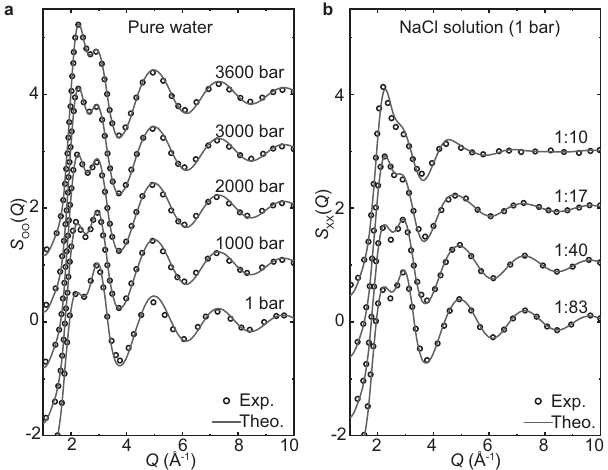
Fig. 1 Reciprocal-space structure of pure water and NaCl solutions. a Experimental 41,52 and theoretical partial structure factors S OO ð Q Þ , for O atoms in pure water at different pressures. b Experimental 18 and theoretical composite partial structure factors S XX ð Q Þ for NaCl aqueous solutions with salt: water mole ratios 1:83 to 1:10, at 1 bar. S XX ð Q Þ contains O – O, O – ion, and ion – ion correlations, S XX ð Q Þ ¼ ∑ α ; β w αβ S αβ ð Q Þ ; α ; β 2 O ; Na ; Cl f where α , β are the atom types and w αβ is the corresponding weight. All structure factors were shifted vertically for visual